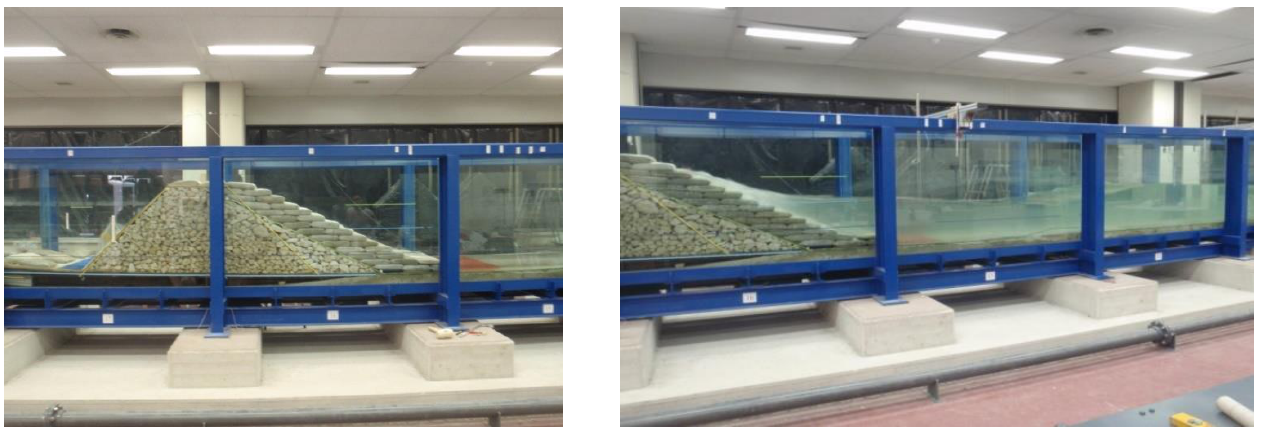
Figure 6. GSC revetment structure with a slope of 1:2.